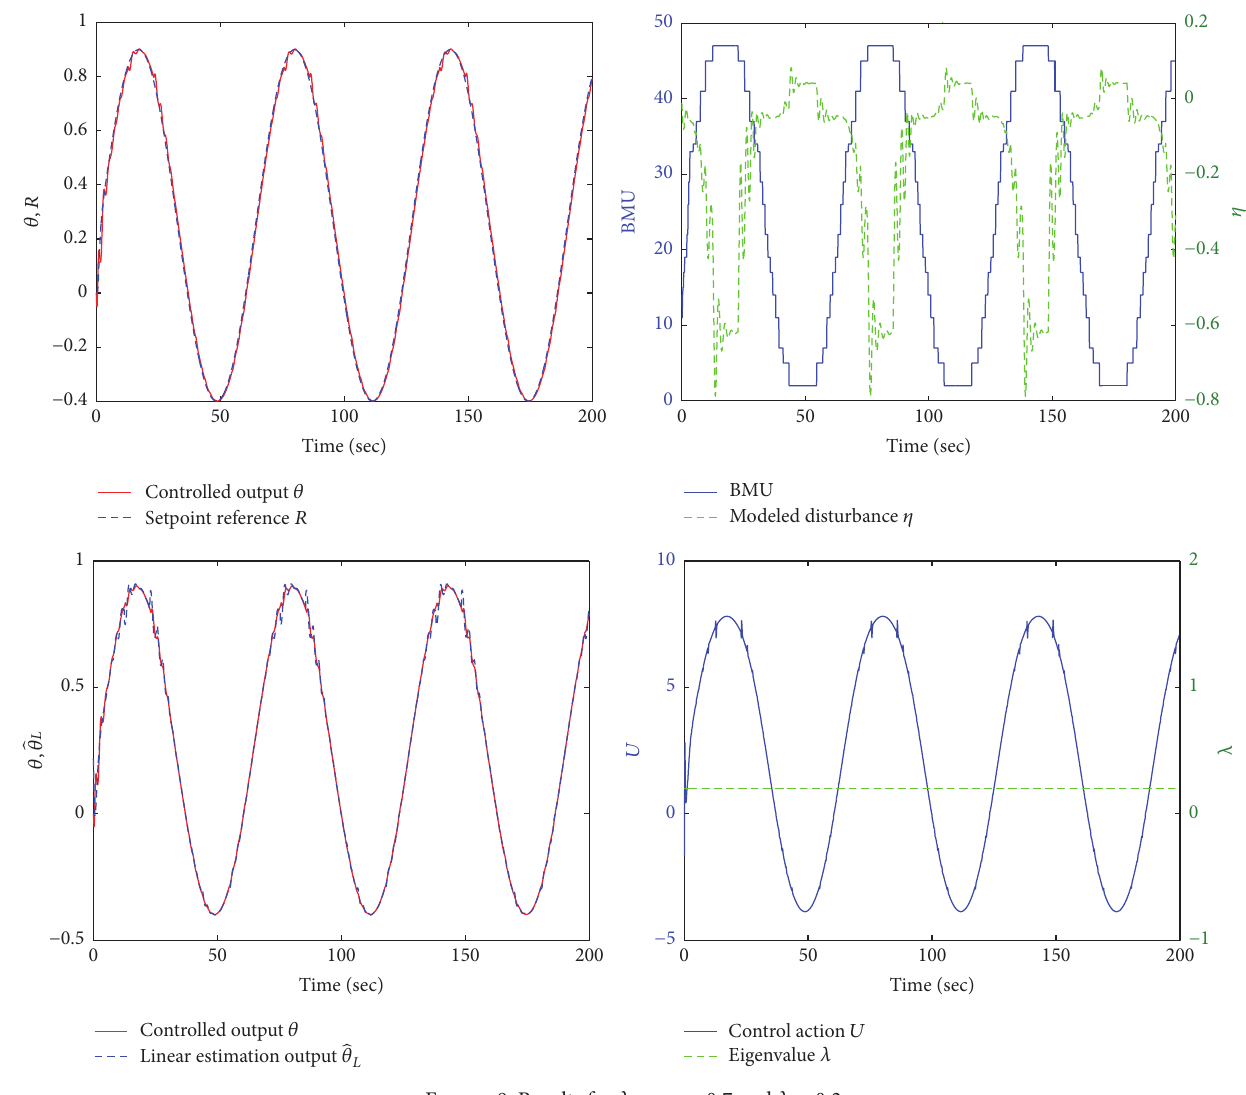
Figure 8: Results for 𝜆 prefilter = 0.7 and 𝜆 = 0.2